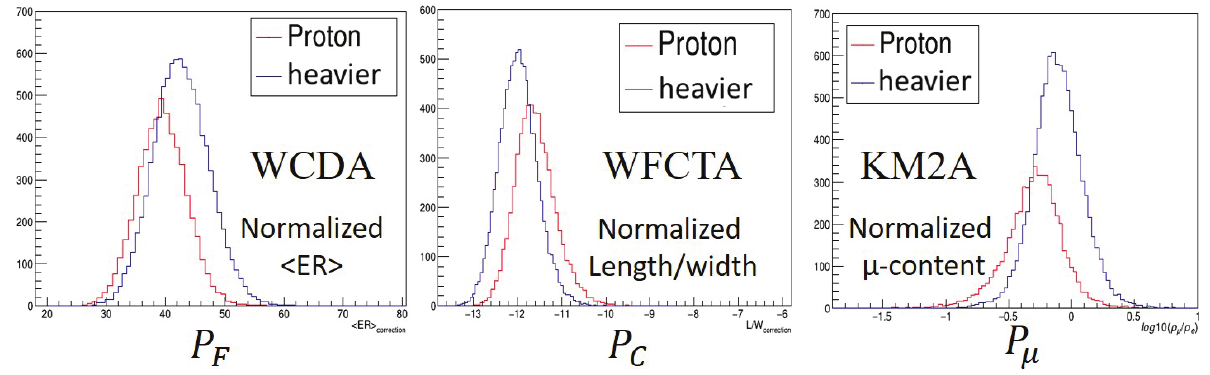
Figure 5. Primary species sensitive shower parameters measured by WCDA ( P F ), WFCTA ( P C ) and KM2A ( P μ ), respectively. Dis- tributions of those parameters of showers induced by protons are in red. The same distributions of showers induced by Helium and heavier nuclei are in blue, according to the composition model by Gaisser et al. [16].